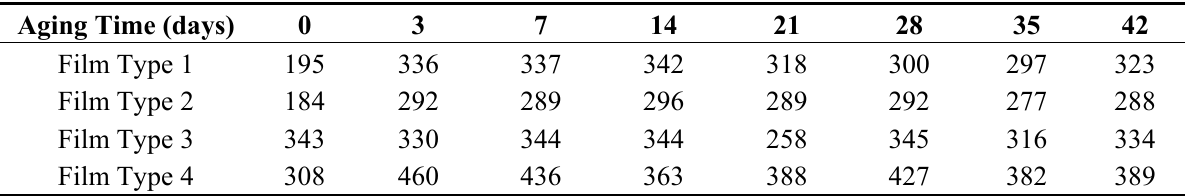
Table A1. The modulus of elasticity (unit: ksi) vs. aging time at a 100 °C aging temperature for film Types 1–4, which have the same film thickness (5 mil), but various layer thicknesses.